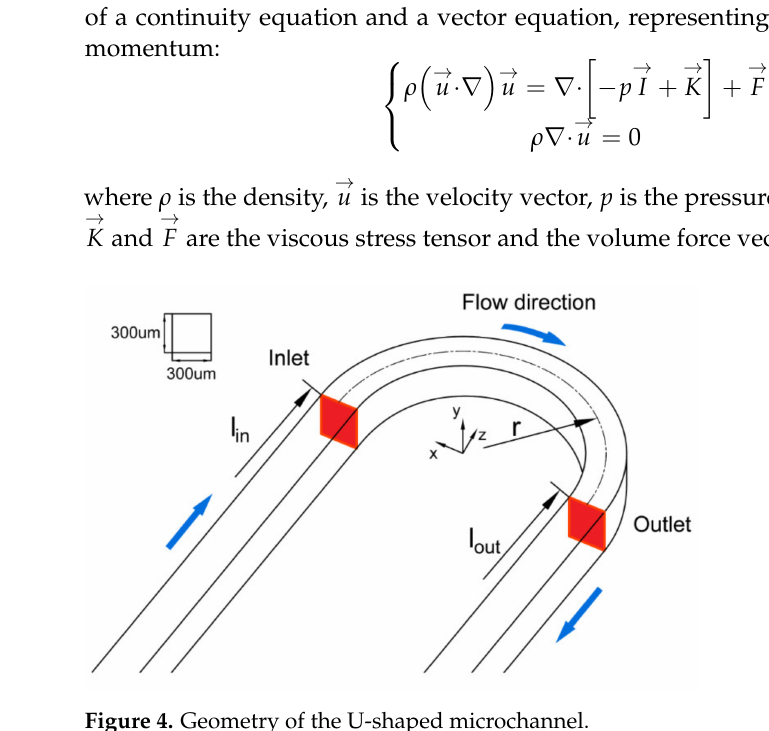
Figure 4. Geometry of the U-shaped microchannel.